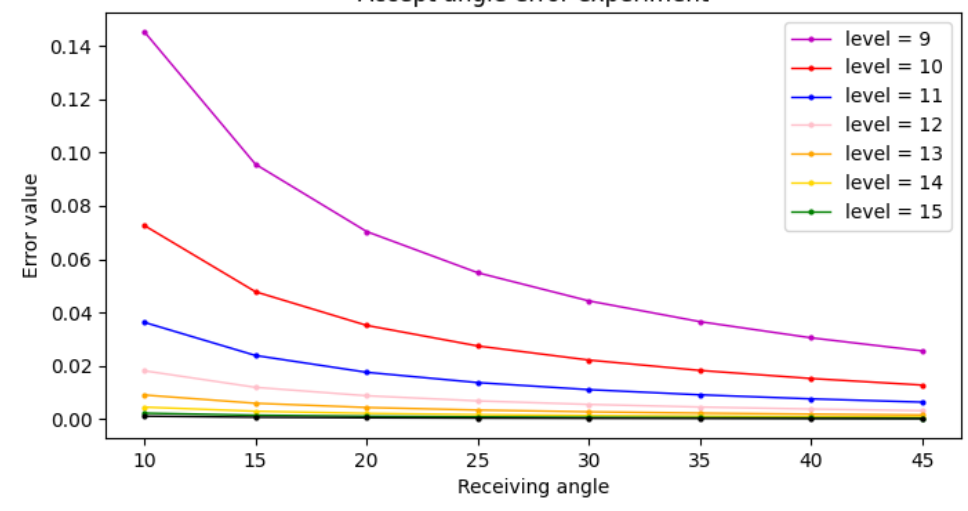
Figure 11. Impact of maximum angle on grid calculation.